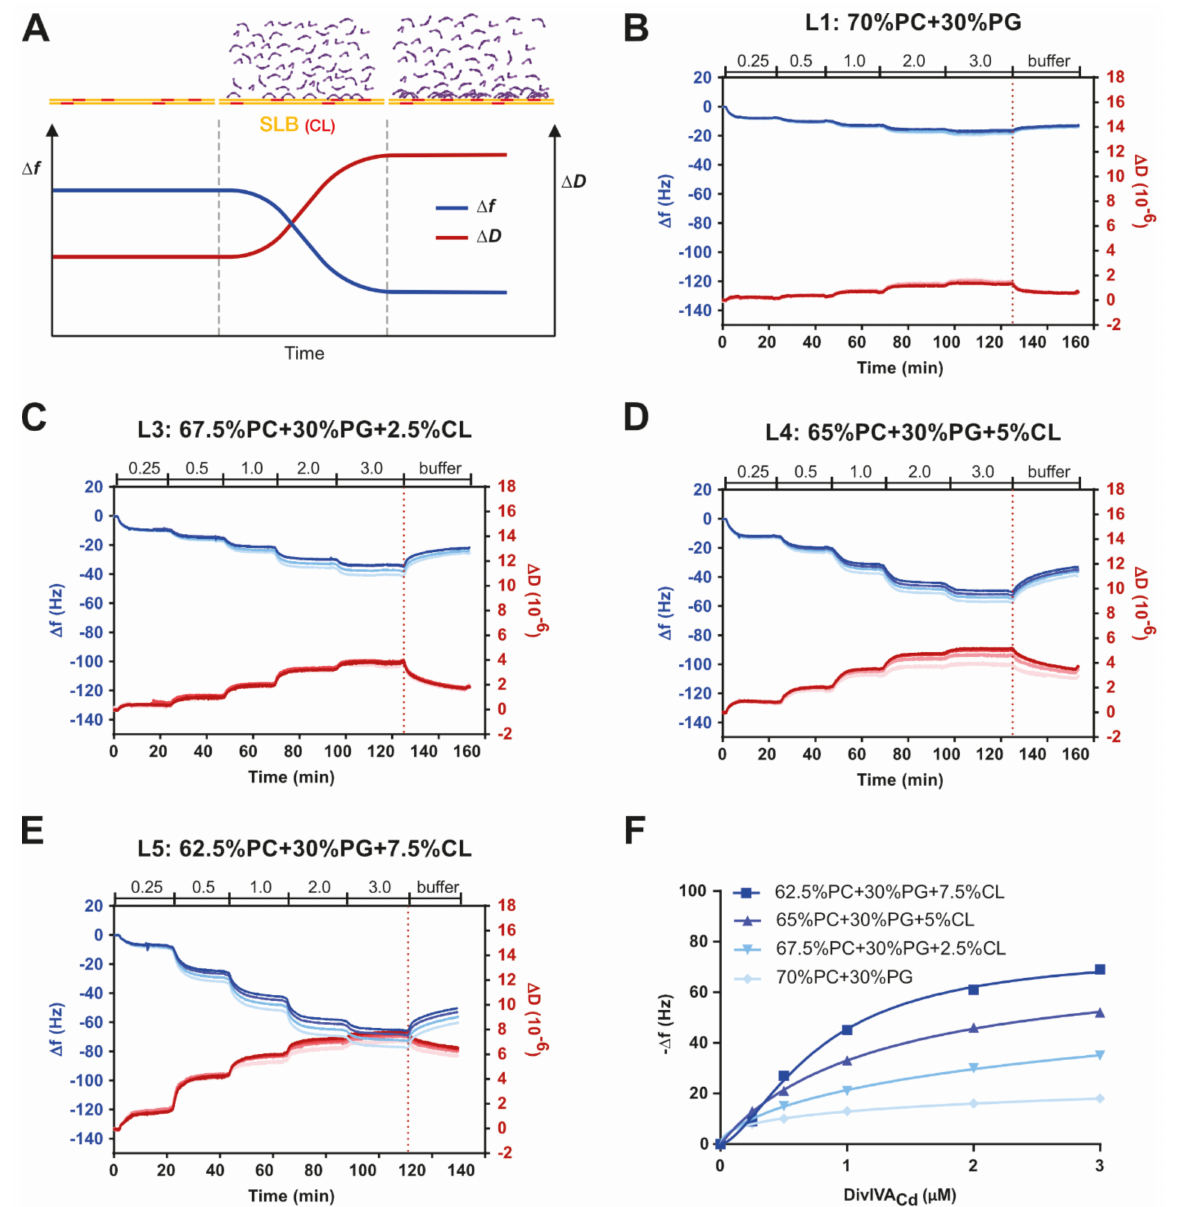
Figure 2. QCM-D measurements confirm that DivIVA Cd binding depends on the lipid composition. ( A ) Simplified scheme of the QCM-D experiment. Full-length DivIVA Cd (violet) was layered over the SLB on the QCM-D sensor chip. While the sedimentation assay investigated the binding of DivIVA Cd to vesicles of different lipid composition, this experiment examined the ability of DivIVA Cd to bind to different lipid bilayers. The DivIVA Cd illustration is based on the structure of the full-length DivIVA Bs tetramer [38]. The illustration was adapted from biolinscientific.com. ( B – E ) Results from measurements using supported lipid bilayers (SLBs) containing different cardiolipin concentrations. Layers were formed on a silicon dioxide-coated surface of a quartz crystal from a suspension of liposomes. DivIVA Cd was added to the SLB stepwise, starting with 0.25 µ M after t = 1 min, followed by 0.5, 1.0, 2.0, and 3.0 µ M DivIVA Cd , as indicated on the top margin of each plot, and the frequency ( ∆ f) and dissipation ( ∆ D) changes were measured. The plots show ∆ f (in blue) and ∆ D (in red) of the third, fifth, seventh, and ninth overtones (lower overtones are in lighter shades, the highest overtone is the darkest shade) normalized to the baseline obtained after SLB formation. ( F ) A summary plot of the normalized ∆ f7 versus DivIVA Cd concentration shows a clear preference of DivIVA Cd for the SLB with CL. The ∆ f7 curve is reversed, meaning that the ascending curve indicates increased mass absorption. The series were fit non-linearly to the Hill